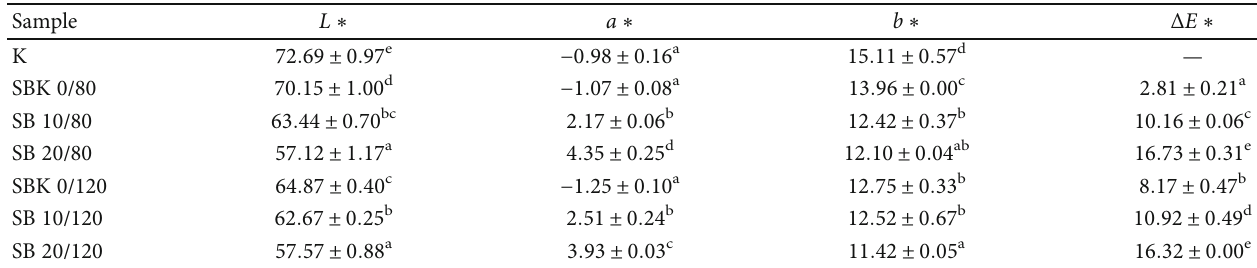
Table 6: Color parameters of analyzed bread